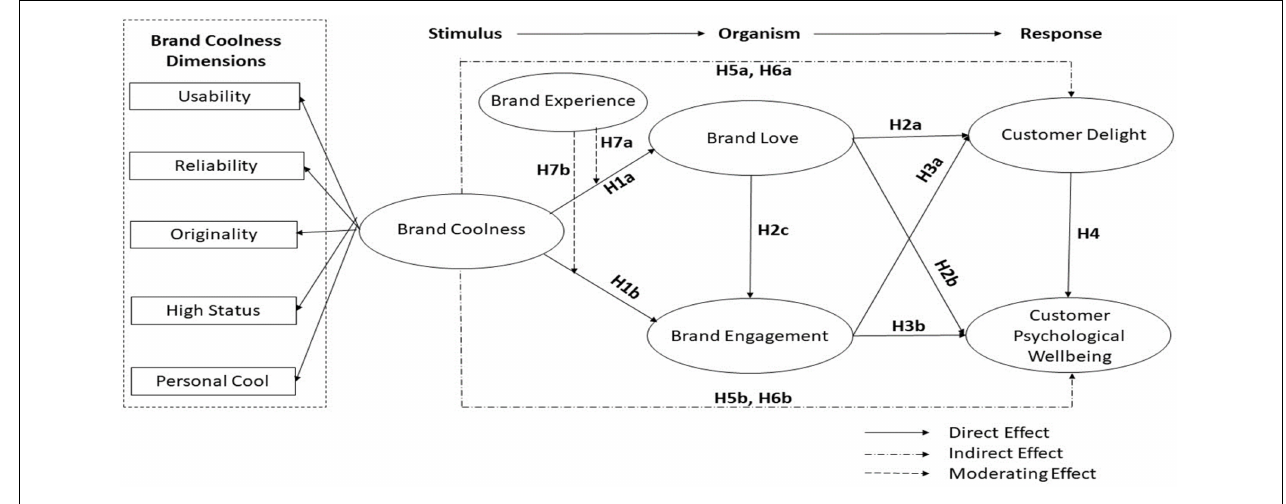
FIGURE 1 | Theoretical